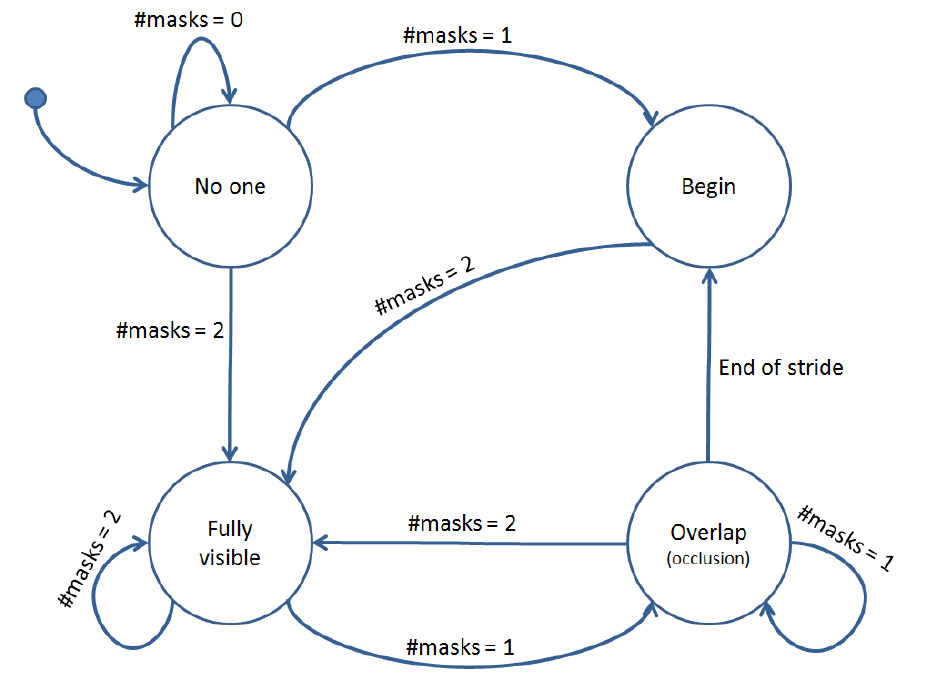
Figure 6. This figure provides the state diagram of the possible states of each frame in the captured pedestrian